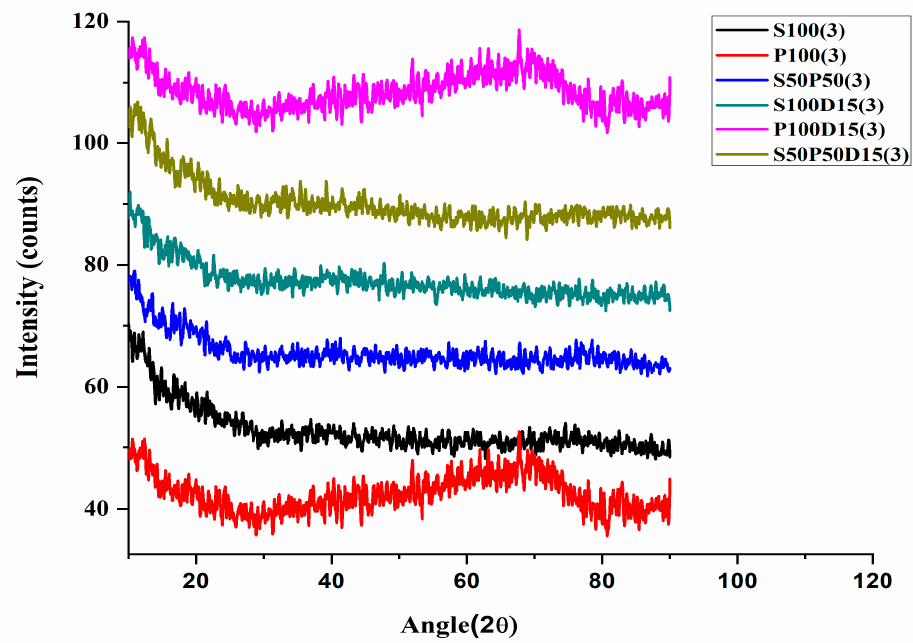
Figure 2. XRD patterns of drug-loaded (and unloaded) SA/PVA-MMT clay reinforced nanocomposite films. In all the unloaded drug samples, S100(3), P100(3), and S50P50(3), the ratio of SA and PVA is different while the amount of clay is constant (i.e., 3%). In these samples, the drug was absent. XRD studies revealed that SA is amorphous [37], since there was no sharp diffraction peak, while PVA has a crystalline nature with two characteristic peaks at 2 θ = 20 ◦ and 2 θ = 40 ◦ [38]. In all samples, characteristic peaks at 2 θ = 10.6 and 2 θ =19.7 appeared with d-spacing of 8.3 and 4.5, respectively. All other peaks in samples are due to the presence of MMT and its interaction with polymers. Sharp peaks in the sample S100(3) appeared, as it contains only SA and organically modified MMT, so the crystalline nature of this sample may be due to the presence of MMT, as it is highly crystalline. MMT gives a sharp peak at 2 θ = 8.5 ◦ , but this peak is shifted towards the lower 2 θ value; this is explained by the intercalation of polymer into clay sheets [39]. It also gives broad peaks in the range of 2 θ = 5–6 ◦ . In an analogous way, the formulations S100(3), S50P50(3), S100D15(3), and S50P50D15(3) gave broad peaks at 2 θ = 19.7 ◦ , 2 θ = 19.5 ◦ , and 2 θ = 20.8 ◦ . The broad peak is observed because of the amorphous nature of SA, while formulations S50P50(3) and S50P50D15(3) consist of PVA in addition to SA and MMT clay. PVA showed sharp characteristic peaks at 19.5 ◦ , 22.7 ◦ , and 40.6 ◦ due to the crystalline character and strong H-bonding between hydroxyl (-OH) groups. The slight variations in the 2 θ values of PVA and SA peaks were due to the semi-crystalline nature of blends. The peak at 2 θ = 13.73 ◦ is from SA, which consistently appears in all the samples except P100(3) and P100D15(3). The second sample, P100(3), showed two peaks of PVA at 2 θ = 22 ◦ and 2 θ = 41 ◦ . This sample had less intense peaks as compared to sample S100(3), which may be attributed to the fact that PVA underwent exfoliation with MMT or a weak hydrogen bonding was formed between clay and PVA functional groups which decreased the interplanar spacing and less intense peaks were observed [39,40]. XRD results showed the possible interaction of SA and PVA by making H-bond between the hydroxyl group of PVA and carboxyl or the hydroxyl group in SA which might hinder the crystalline structure of SA by making strong molecular interaction. In all the XRD patterns of SA/PVA, 2 θ = 19.6 ◦ was observed, and the peaks of pure SA and PVA were absent. This amorphous behavior resulted from weak interactions produced due to the blending of polymers. If the polymers were not blended properly, the respective peaks of both the polymers would have appeared separately. In all the loaded drug samples, S100D15(3), P100D15(3), and S50P50D15(3), the drug showed intense peaks at 2 θ = 19 ◦ , 2 θ = 20 ◦ , and 2 θ = 21 ◦ , as it has a crystalline nature.